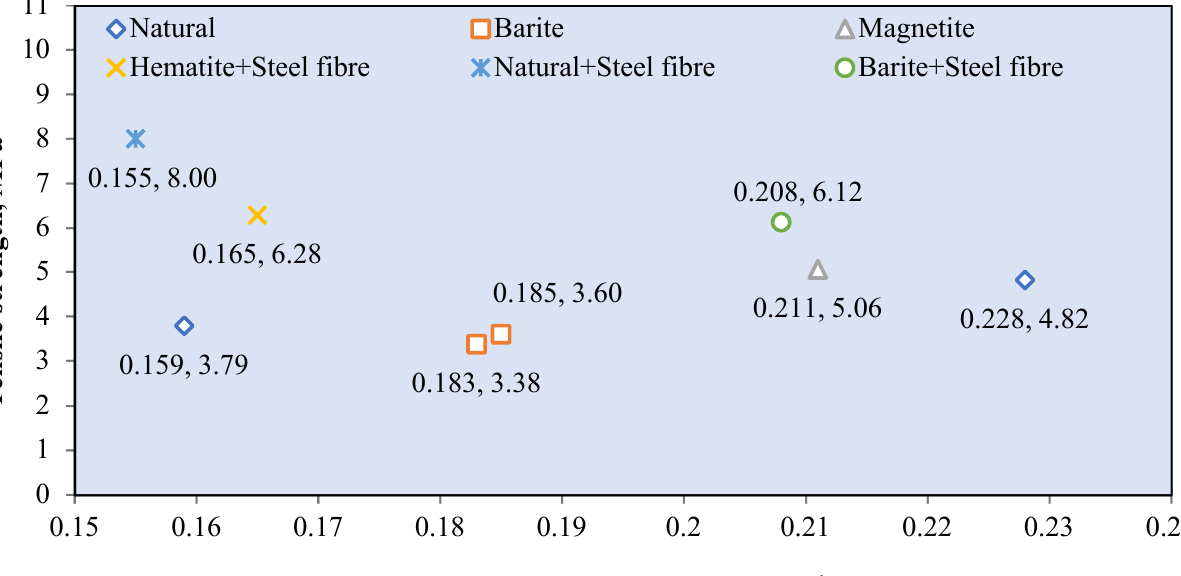
Figure 15. Tensile strength and linear attenuation coefficient of various RSCs (data adapted from [12,18,24,65,122,127]).